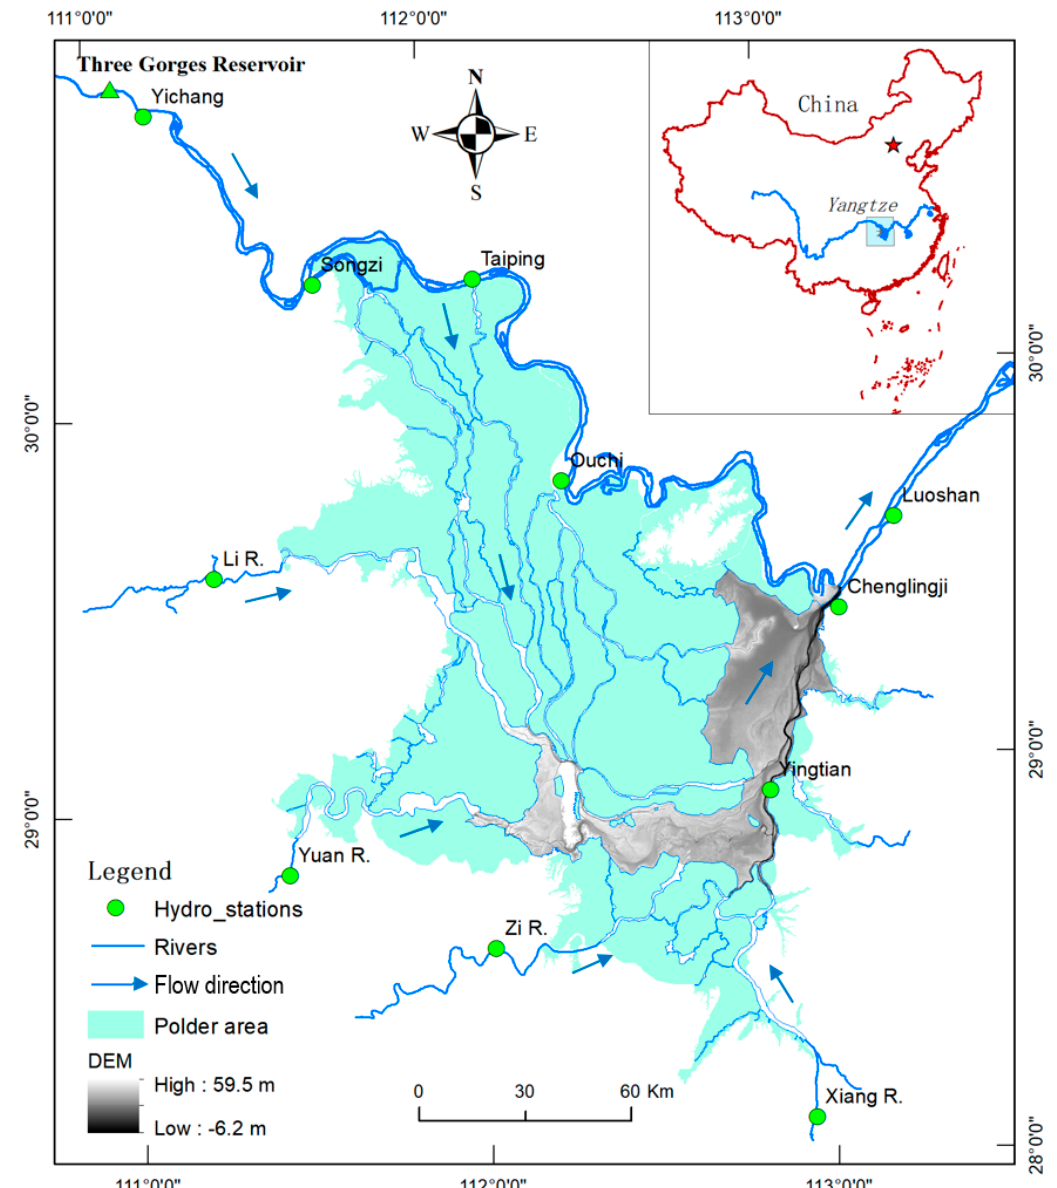
Figure 1. Lake basin, complex hydrological networks, lake–river relationship, and gauging stations in the Dongting Lake region.